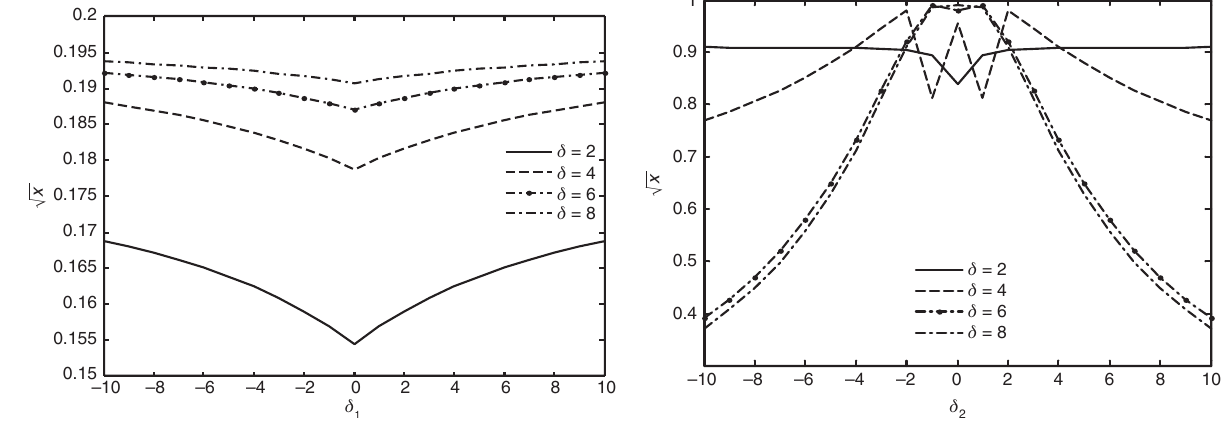
Figure 8: Variations of non-dimensional phase speed ( ) x against impedance parameter δ